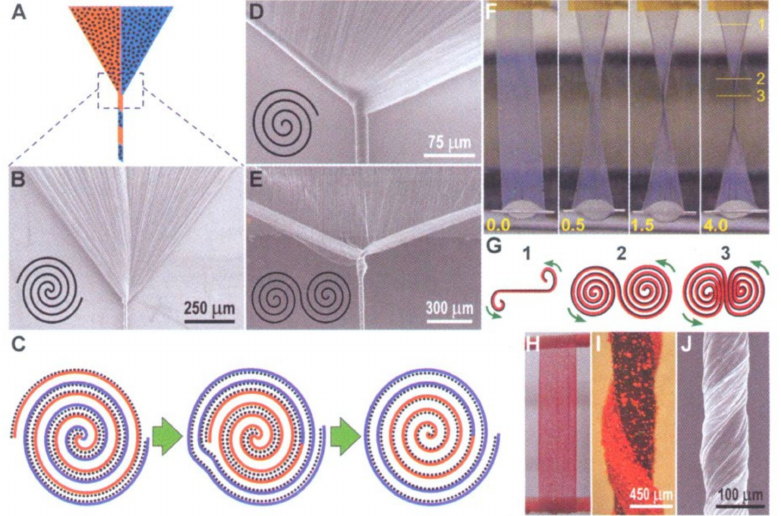
Figure 8. ( A ) Schematic of a twist induced in a CNT spinning web. The active loaded material is rep- resented by black dots. ( B ) SEM image showing a Fermat-type twist (Fermat scroll shown in the inset). ( C ) Change from a Fermat to Archimedean scroll. ( D ) Archimedean scroll. ( E ) Dual Archimedean scroll. ( F ) Sequential pics of a liquid-state twist insertion in a multiwalled CNT(MWCNT) with filtration of the deposited boron nitride nanotubes. ( G ) Cross-sections of several twists marked in ( F , H , I ) pictures of actual MWCNTs colored with red paint, both unscrolled and scrolled. ( J ) SEM image of 70% Ti@MWCNT biscrolled yarn produced by symmetrically inserting a twist in a bilayer rectangular sheet supported in a liquid bath. Reprinted with permission from